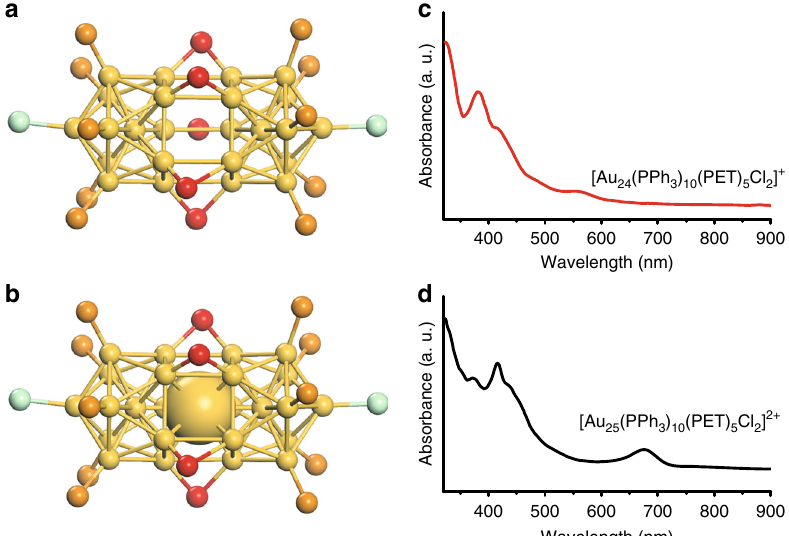
Fig. 1 X-ray structures and UV – Vis spectra of Au 24 and Au 25 nanoclusters. X-ray structures of the hollow Au 24 rod with the central atom dislodged ( a ), and the Au 25 rod ( b ) 36, 37 , the central gold atom in the Au 25 rod is shown using space- fi lling model for clarity. Color code: Au, yellow; P, orange; S, red; Cl, green. C and H atoms are not shown for clarity; UV – Vis spectra of the hollow Au 24 rod and the Au 25 rod are shown in c and d ,